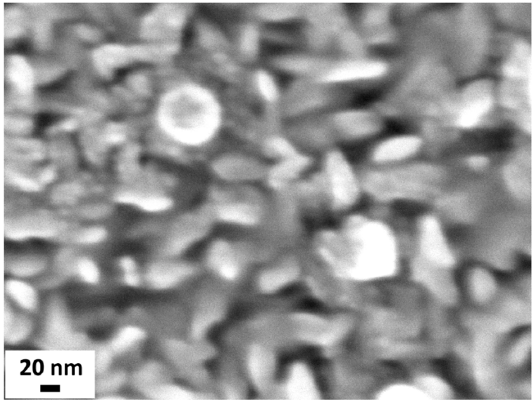
Figure A1. SEM image of the TiO 2 structure with 25 nm thickness without PV4D4 polymer thin film.